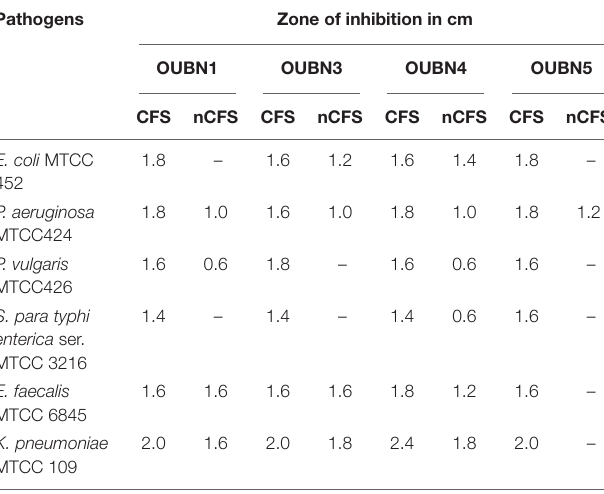
TABLE 6 | Antimicrobial activity against enteric pathogens shown by LAB isolated from toddy palm nectar samples Pathogens Zone of inhibition in cm